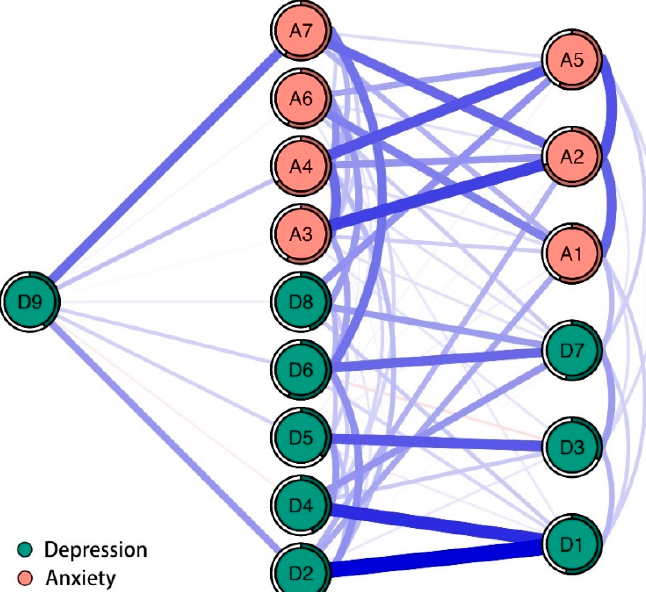
Figure 3. Flow network of suicidal thoughts. Blue edges represent positive correlations, red edges represent negative correlations. The thickness of the edge reflects the magnitude of the correlation. The circles around nodes depict their predictability. D1 = Anhedonia; D2 = Feeling depressed or hopeless; D3 = Sleep problems; D4 = Energy loss; D5 = Appetite changes; D6 = Feeling of worthlessness; D7 = Trouble concentrating; D8 = Psychomotor issues; D9 = Suicidal ideation; A1 = Feeling nervous or anxious; A2 = Unable to control worry; A3 = Excessive worry; A4 = Relaxation difficulty; A5 = Too restless to sit still; A6 = Easily annoyed or irritable; A7 = Afraid something awful might happen.